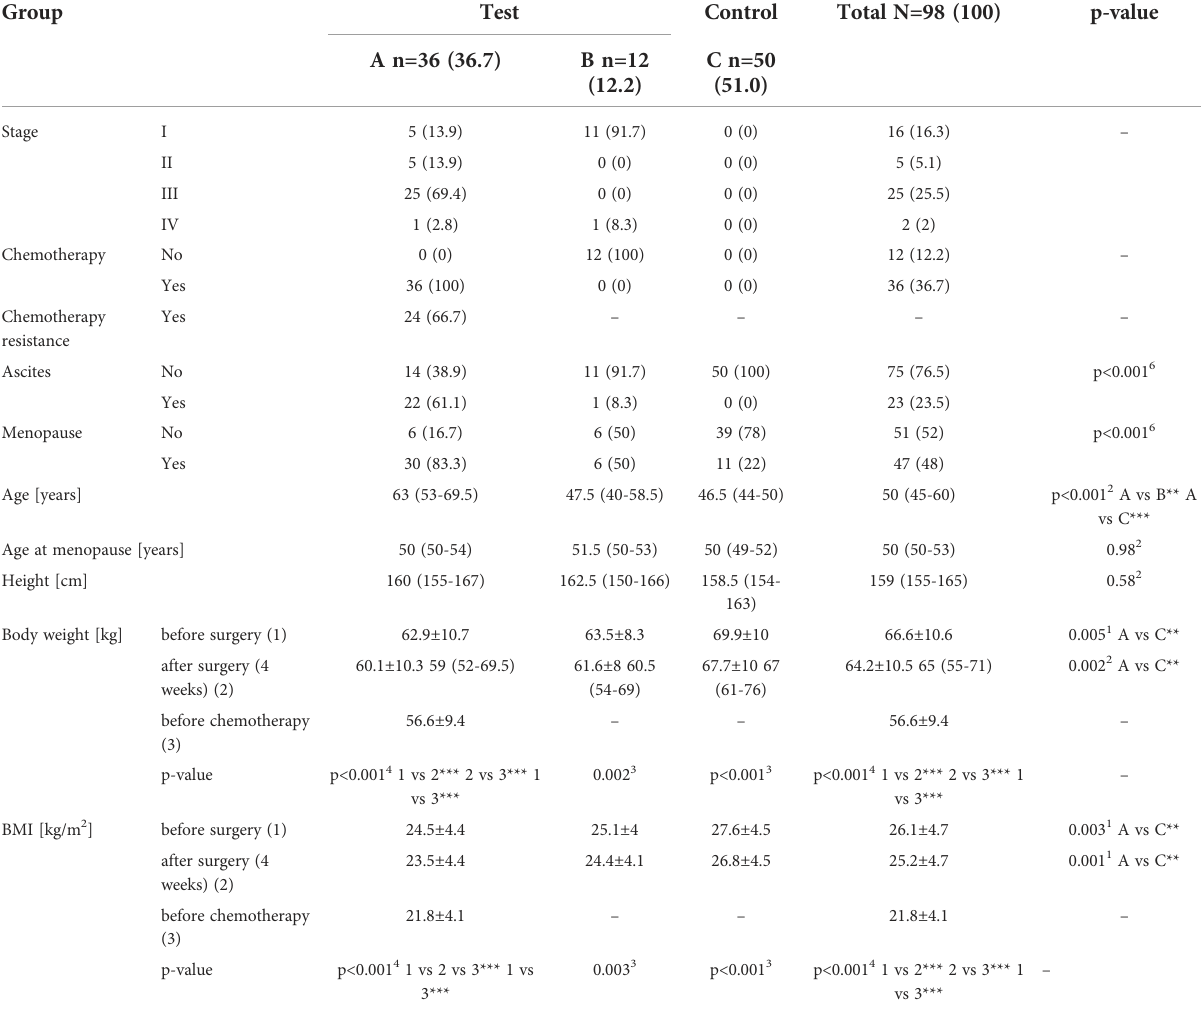
TABLE 1 Clinical and anthropometric data of patients with histopathologically con fi rmed diagnosis of stage I-IV ovarian cancer (groups A and B) and control subjects (group C). Group Test